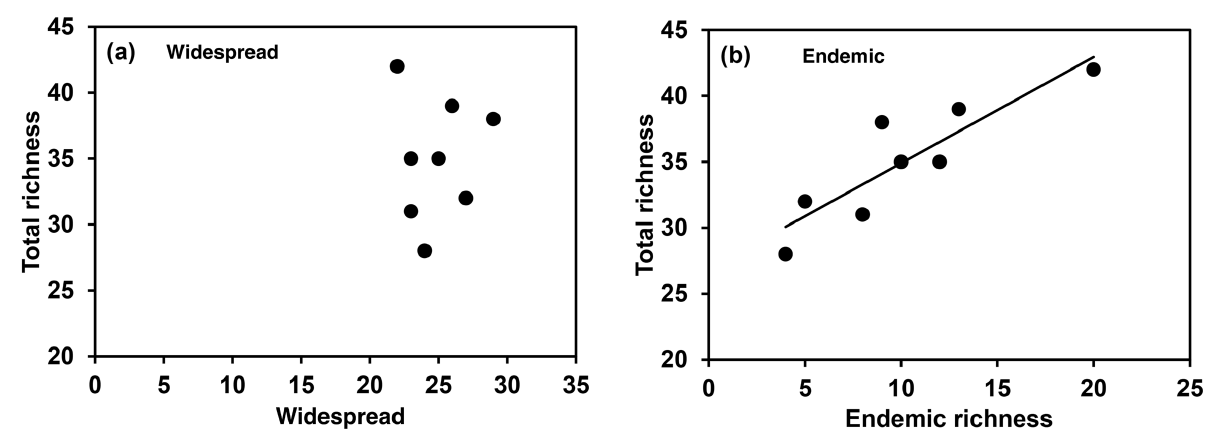
Figure 4. Relationship between species richness and the number of (a) widespread species and (b) narrow-range endemic species. Whereas the number of widespread species was unrelated to total species richness ( R 2 = 0.00, p = 0.901), the number of narrow-range endemic species at a site was strongly correlated with total species richness ( R 2 = 0.78, p = 0.003).